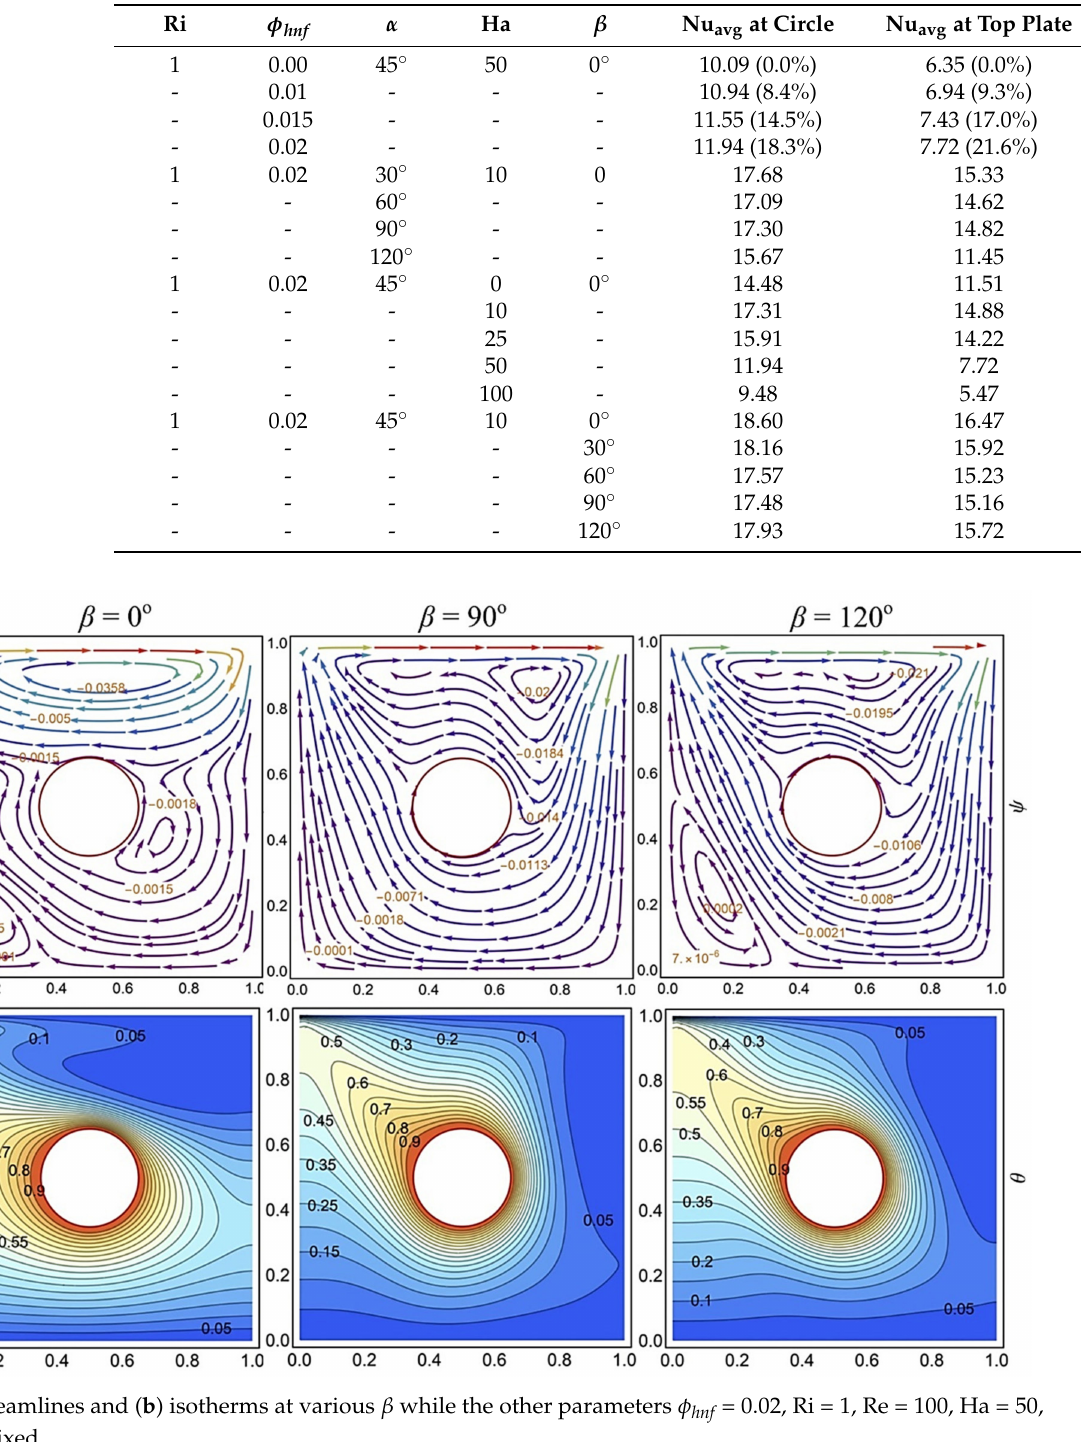
Table 5. The numerical values of Nu avg at the center heater and at the top wall Re = 100, Ri =1.